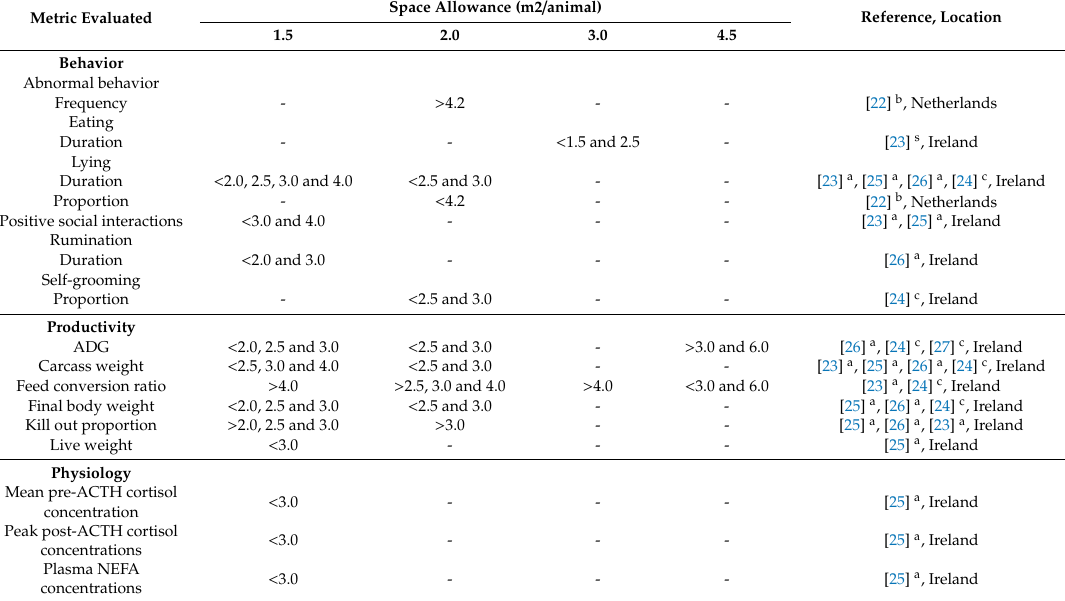
Table 5. Overview of the e ff ect of di ff erent space allowances on beef cattle behavior, productivity and physiology. Space allowances evaluated include 1.5, 2.0, 2.5, 3.0, 4.0, 4.2, 4.5 and 6.0. Space allowances are reported in the same language as they were presented by original study authors. Inclusion of significant results was determined at p < 0.05.